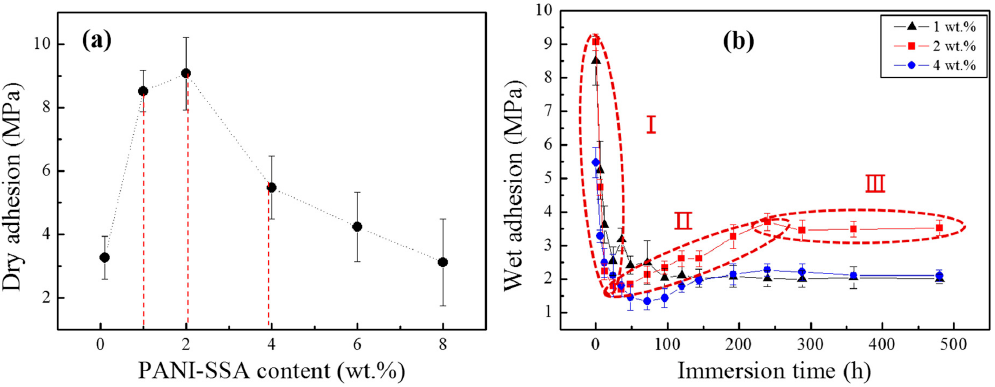
Figure 7. Adhesion results ( a ) with the increase of PANI-SSA content; ( b ) with immersion time for the coating/aluminum samples.